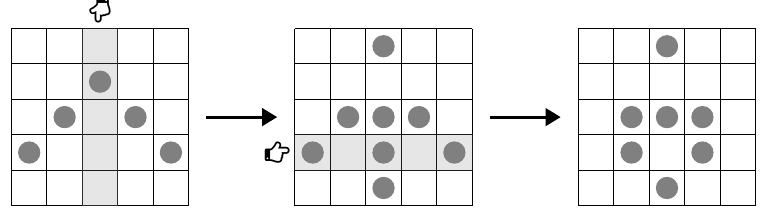
Figure 1. Example moves of a 5 × 5 Gale–Berlekamp switching